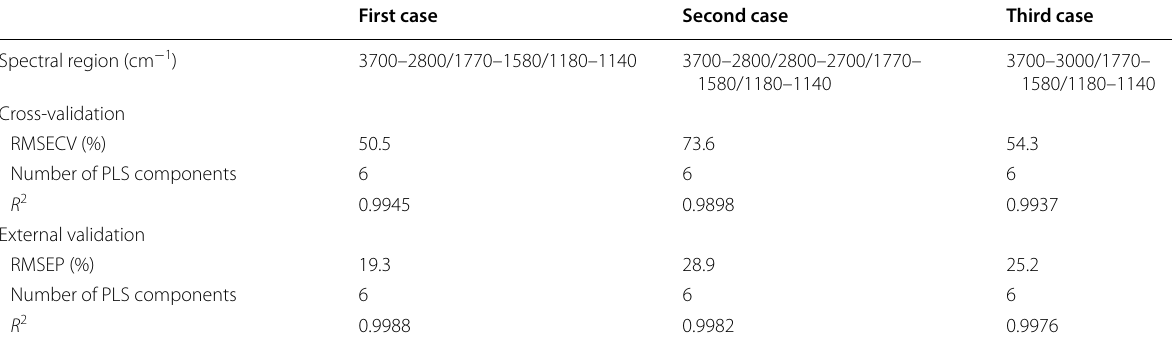
Table 1 PLSR quality parameters for cross- and test set-validation for the proposed three cases